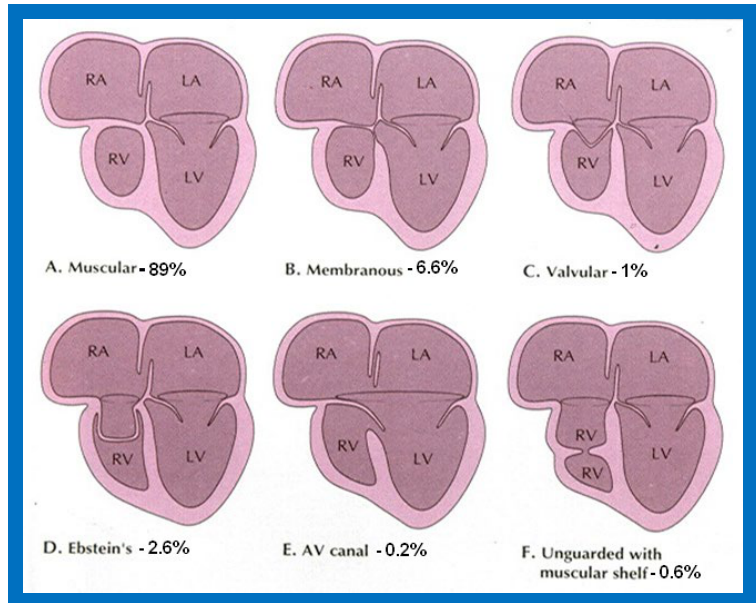
Figure 1. Diagrammatic portrayal of anatomic types of tricuspid atresia based on the morphology of the atretic tricuspid valve. ( A ) muscular type, ( B ) membranous type, ( C ) valvular type, ( D ) Ebstein’s type, ( E ) atrioventricular canal type, and ( F ) unguarded valve with muscular shelf. The prevalence of each type is shown under each diagram. For the sake of simplicity, the great vessels are not shown. Also note that no ventricular septal defects are shown. LA, left atrium; LV, left ventricle; RA, right atrium; RV right ventricle. Modified from Rao PS, Alapati S. Neonatology Today 2012;7(5):1–12 [11].